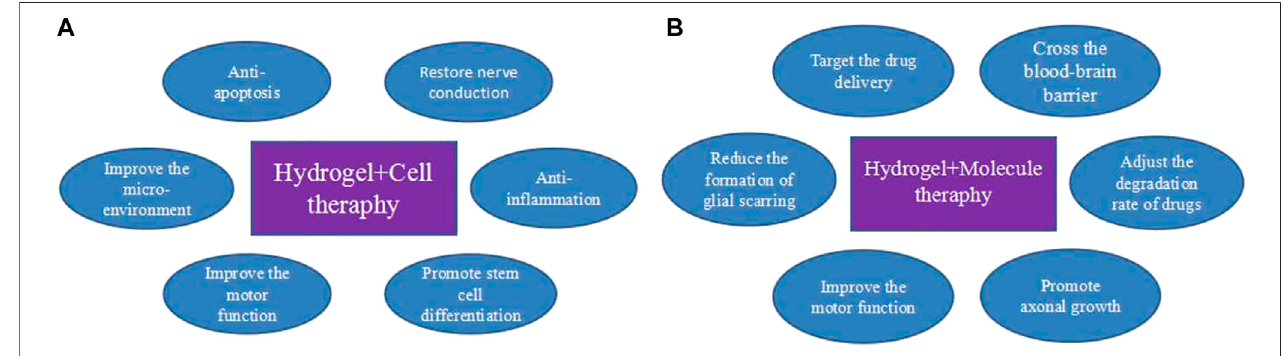
FIGURE 5 | Advantages of hydrogels in the treatment of SCI. (A) Hydrogel combined with cell therapy. (B) Hydrogel combined with molecular